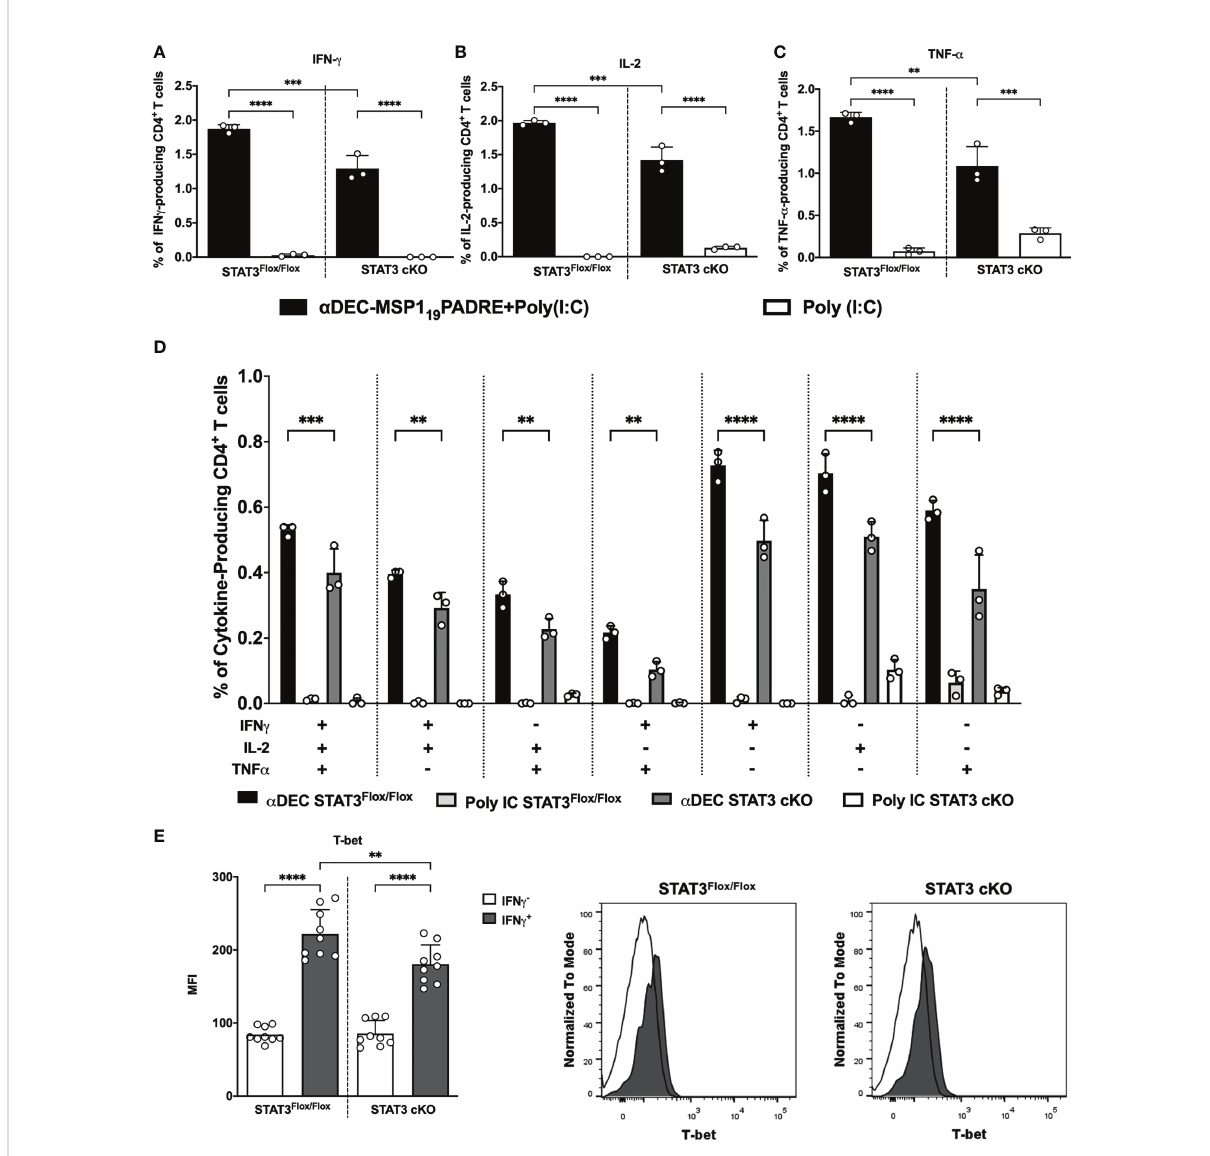
FIGURE 3 STAT3 signaling controls cDC1 ability to prime Th1 immune responses after antigen targeting to the DEC205 receptor. STAT3 Flox/Flox and STAT3 cKO mice were immunized with 5 m g of a DEC205-MSP1 19 PADRE together with 50 m g of Poly (I:C) as adjuvant or only Poly (I:C) as a control. A boosting dose was performed 14 days later using only 5 m g of a DEC205-MSP1 19 PADRE or only saline. Splenocytes were obtained 4 days after boosting. Splenocytes were stimulated ex vivo with 5 m g/mL of recombinant MSP1 19 PADRE and incubated for 12 hours. Intracellular cytokine staining was performed after fi xation and permeabilization. Graphs show the percentage of (A) IFN- g -, (B) IL-2- and (C) TNF- a -producing CD4 + T cells. (D) Boolean gating on CD4 + T cells displaying polyfunctional cytokine-producing cells. (E) T-bet expression was determined in IFN- g - producing CD4 + T cells. Histograms represent IFN g + CD4 + T cells in black and IFN g - CD4 + T cells in white. Bars show mean ± SD of one representative result out of 3 independent experiments (n=3 animals/group) in (A – D) and from three experiments pooled together (n=9 animals/group) in (E) **p<0.01, ***p<0.001, ****p<0.0001, and ns not signi fi cant; one-way ANOVA followed by Tukey ’ s